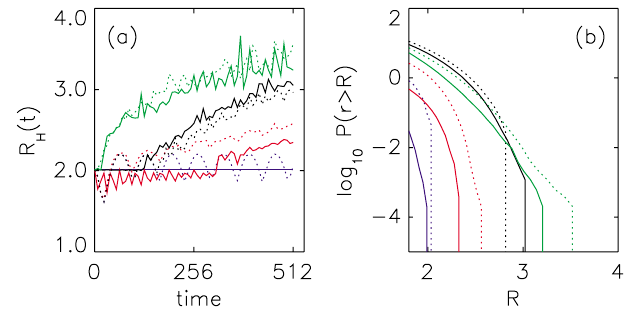
FIG. 8. (Color) Halo distributions ( N (cid:2) 10 6 ) for radial orbits (dotted curves) and initially circular orbits (solid curves). (cid:6) t (cid:7) vs t with (cid:13) (cid:2) 0 : 05 , (cid:13) (cid:2) 0 , and t (cid:2) (a) Halo amplitude R H c 1 2 80 . (b) Percentage P (cid:6) r > R (cid:7) of test particles lying outside radius R at the end of the simulation ( t (cid:2) 512 ). Blue curves: hj (cid:22)! ji (cid:2) 0 ; red curves: hj (cid:22)! ji (cid:2) 0 : 001 ; black curves: hj (cid:22)! ji (cid:2) 0 : 01 . Green curves: hj (cid:22)! ji (cid:2) 0 : 1 (cid:6) (cid:11) 2 (cid:7) t (cid:10) , and in turn put R (cid:4) 2 (cid:6) t (cid:7) ! R ! 1 (cid:9) (cid:6) M (cid:4) 1 (cid:7) cos (cid:8) ! 1 (cid:6) (cid:11) 2 (cid:7) t (cid:10) in Eq. (10). By comparing the 1 (cid:4) 2 (cid:6) M (cid:4) 1 (cid:7) cos (cid:8) ! 1